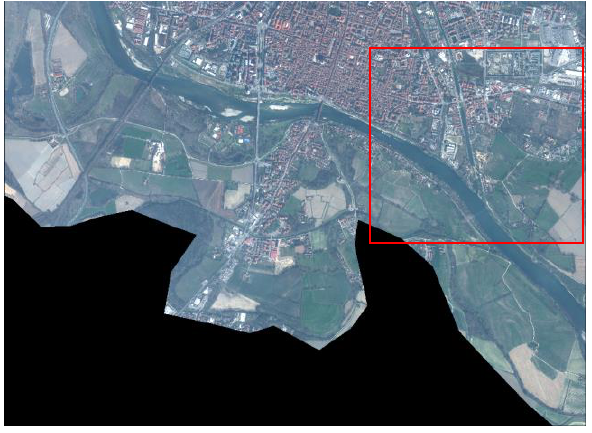
Figure 4. Degree of detail achieved in the panchromatic